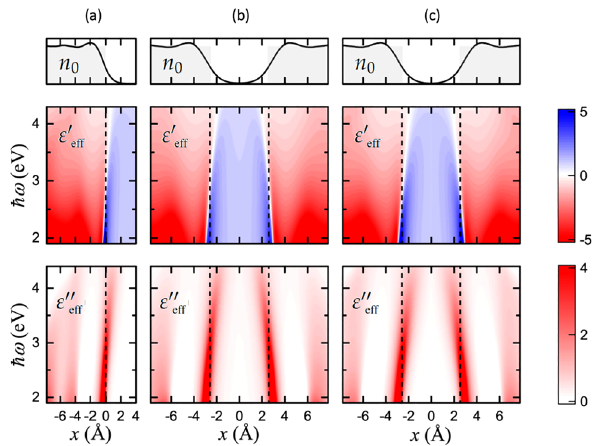
Figure 15: Plot of the spatial and spectral dependence of the real (middle row) and imaginary (lower row) parts of 𝜀 ( r ,𝜔 ) = 𝜀 ′ ( r ,𝜔 ) + i 𝜀 ′′ ( r ,𝜔 ) in the near vicinity of the jellium eff eff eff surface. For completeness, the top row illustrates the associated ( r ). (a) A single semi-infinite jellium equilibrium electron density n 0 surface. (b) Superposition of two independent semi-infinite jellium surfaces, with no inter-surface charge transfer. (c) Two fully coupled jellium surfaces, including the possible inter-surface charge transfer associated with quantum tunneling. Figure adapted from Ref. [244] ( © 2017 World Scientific Publishing